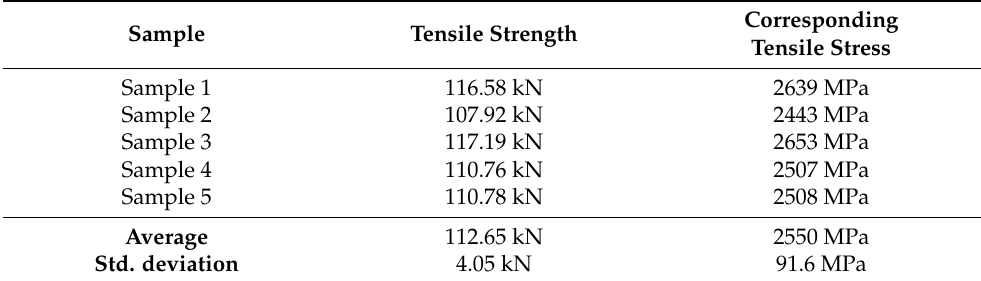
Table 4. Tensile strength with resin cast